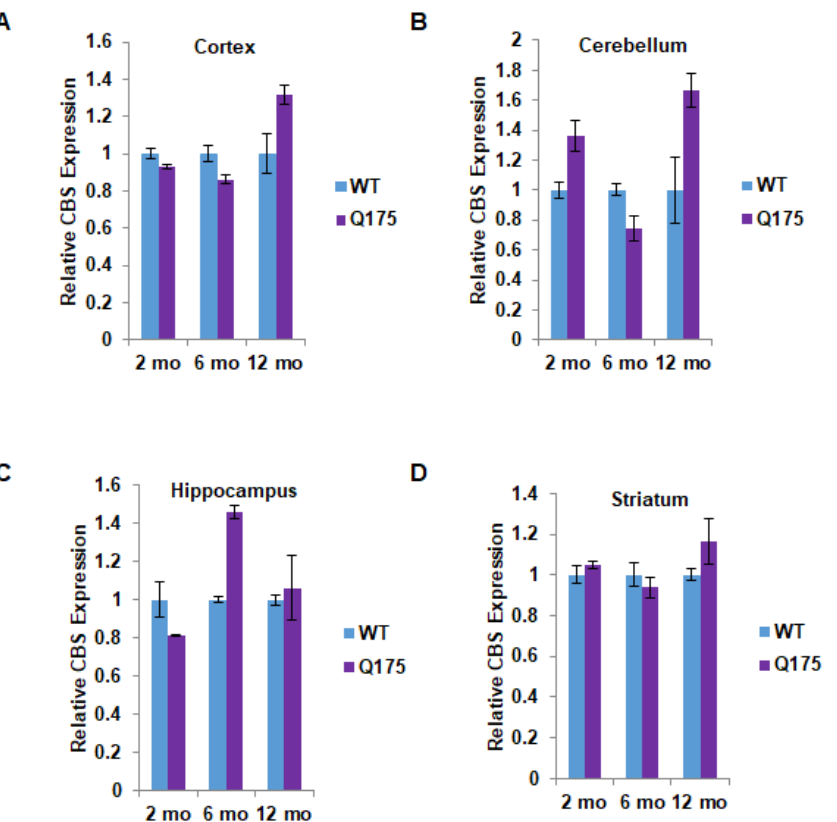
Figure 2. Quantitation of cystathionine β -synthase (CBS) expression in the Q175 model of Huntington’s disease. ( A ) Expression of CBS at 2, 6, and 12 months in the cortex in Q175 mice and their wild-type counterparts. ( B – D ) Expression of CBS at 2, 6, and 12 months in the cerebellum, hippocampus, and striatum in Q175 mice. n = 3, SEM.